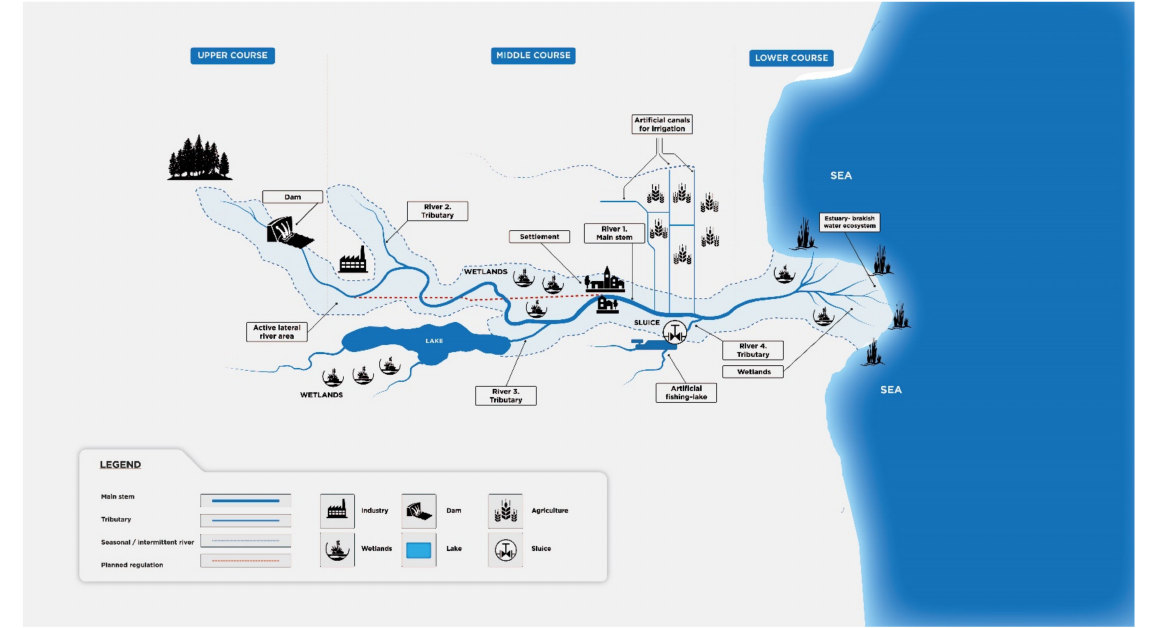
Figure 3. The structure of larger rivers, which can be used as inland waterways connecting natural and artificial ecosystems. It is important to consider how possible regulation and changes in land use might affect the natural ecosystems connected by these rivers. Source: own design.